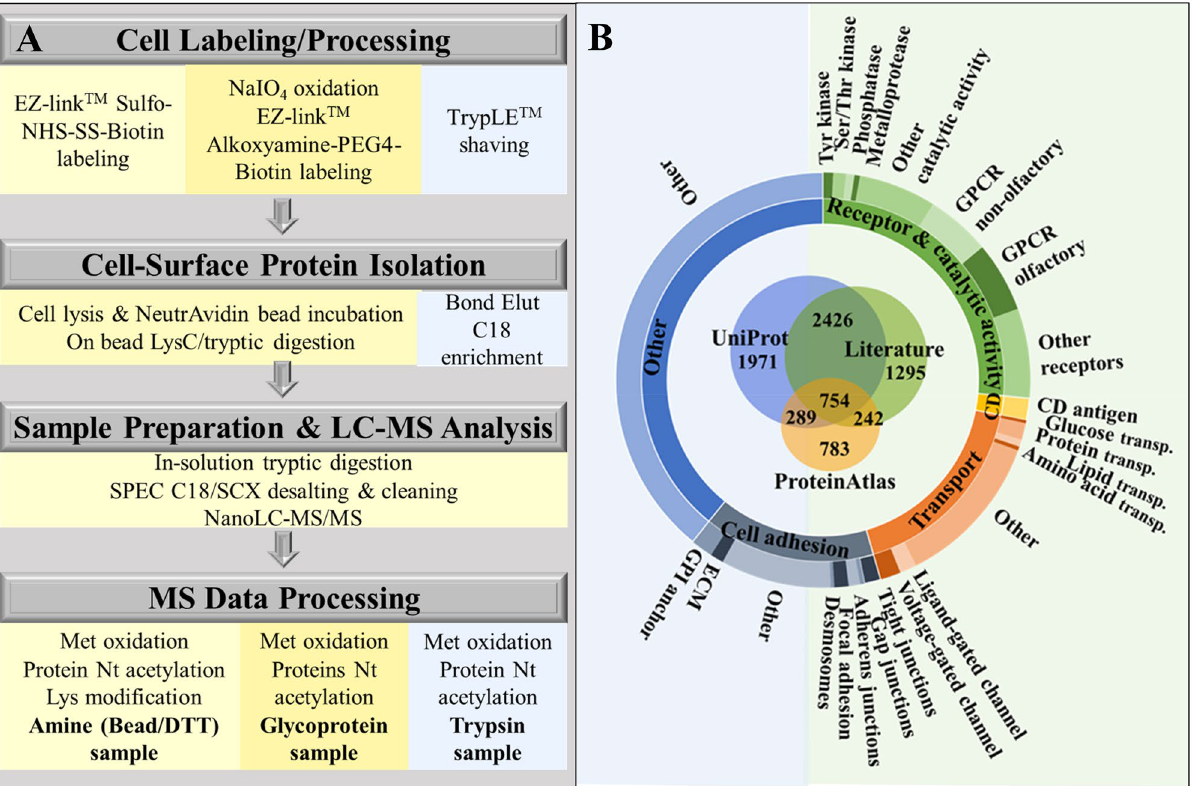
Figure 1. Cell-membrane protein isolation flowchart and database classification. ( A ) SKBR3 cell-membrane protein isolation and processing workflow via three distinct methods: biotin labeling of protein primary amine groups, biotin labeling of glycoproteins, and enzymatic shaving. ( B ) In-house built database of 7760 cell- membrane proteins classified based on GO controlled vocabulary a Nikon Eclipse Ti2 with a 40X water objective. The images were processed with Nikon software Denoise.ai and NIS-Elements AR Analysis 5.11.01. Cell‑membrane protein labeling and harvesting. To isolate the cell-membrane fraction of SKBR3 cells, a combination of chemical labeling and enzymatic approaches was followed (Fig. 1A). Based on reported yields and processing times 8–13 , three methods, relying on protein isolation by biotinylation of amino groups and of glycan posttranslational modifications and affinity pulldown, as well as on tryptic shaving of receptors in cell culture, were chosen. Sulfo-NHS-SS-biotin based isolation of proteins enabled the labeling of primary amino groups at the protein N-terminal (α-amino) and Lys (ε-amino) residues, while alkoxamine-PEG4-biotin based isolation, enabled the labeling of carbohydrate moieties that are commonly encountered on the cell-surface pro- teins. Trypsinization of cells in culture was the least time-consuming method due to minimal processing prior and after sample collection. All reagent solutions were prepared fresh before use, and the reagent and rinse solu- tions that were used for biotin labeling were cooled to 4 °C before adding to the cells. The first labeling procedure involved the use of EZ-Link Sulfo-NHS-SS-Biotin (0.5 mg/mL) for labeling the protein N-terminal and Lys side- chain amino groups. Cells were rinsed twice with DPBS (+ Ca 2+ /Mg 2+ ) and then incubated at 4 °C for 30 min, in the dark, with the biotin reagent. After incubation, the biotin reagent was removed, and each flask was washed twice with 20 mL Tris quenching buffer solution (0.1 M) provided in the kit. The cells were collected by scraping in Tris-buffer (10 mL per flask), and centrifuged for 5 min at 800× g and 4 °C. The second approach involved the labeling of cell-surface glycoproteins with EZ-Link Alkoxyamine-PEG4-Biotin (0.5 mg/mL) following protocols described by the manufacturer and in previous manuscripts 12 , with some modifications. Briefly, the cells were rinsed twice with DPBS (+ Ca 2+ /Mg 2+ ) and incubated at 4 °C for 30 min, in the dark, with 20 mL sodium meta- periodate solution (1 mM, pH 6.5) to oxidize the glycan moieties of cell-surface proteins. The cells were rinsed again, twice, with DPBS (+ Ca 2+ /Mg 2+ ), and incubated with 12 mL biotin reagent solution in the presence of 10 mM aniline at 4 °C for 30 min, in the dark. After the completion of the labeling reaction, the biotin reagent was removed, and each flask was washed twice with 20 mL DPBS (+ Ca 2+ /Mg 2+ ). Cell-surface protein biotinyla- tion of cells was visualized with an inverted Eclipse TE2000-U epi-fluorescence microscope (Nikon, Melville, NY), after staining the cells with Streptavidin Alexa Fluor™ 488 (4 μg/mL). The cells were collected by scraping in 10 mL DPBS and centrifuged for 5 min at 800× g and 4 °C. The labeled cell pellets generated by either proce- dure were frozen at − 80 °C for further processing or subjected to immediate lysis. The third approach consisted of shaving the cell-surface protein ectodomains with TrypLE, a reagent that contains recombinant enzymes for